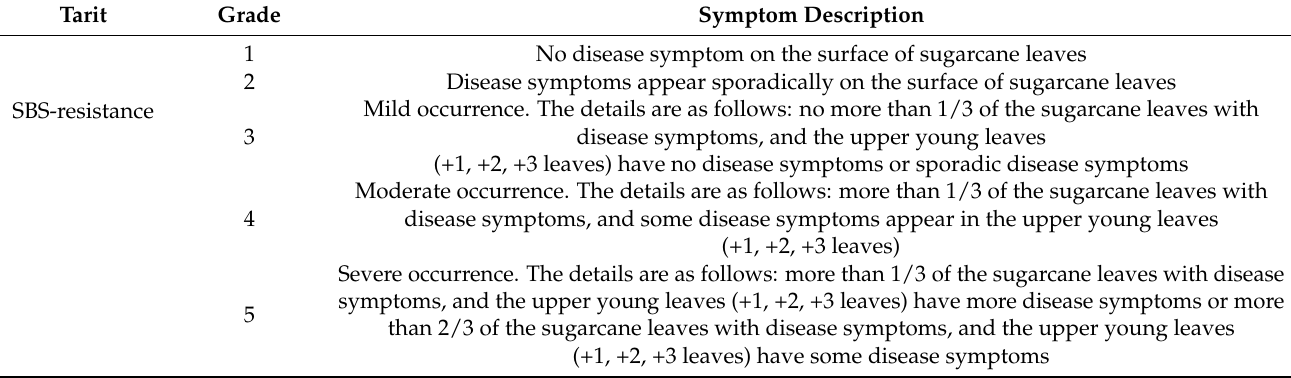
Table 2. Grading scale for field survey of sugarcane brown stripe (SBS) infected by H. stenospilum in